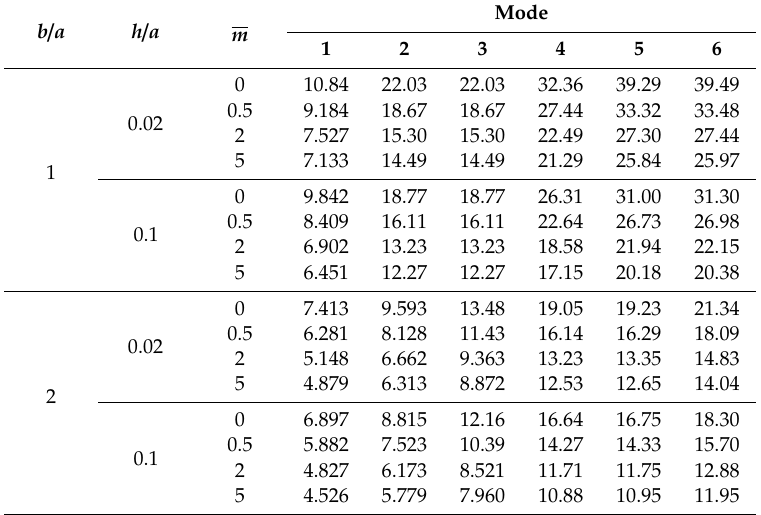
Table 7. Nondimensional natural frequencies Ω of CCCC Al / Al 2 O FGM rectangular plates.